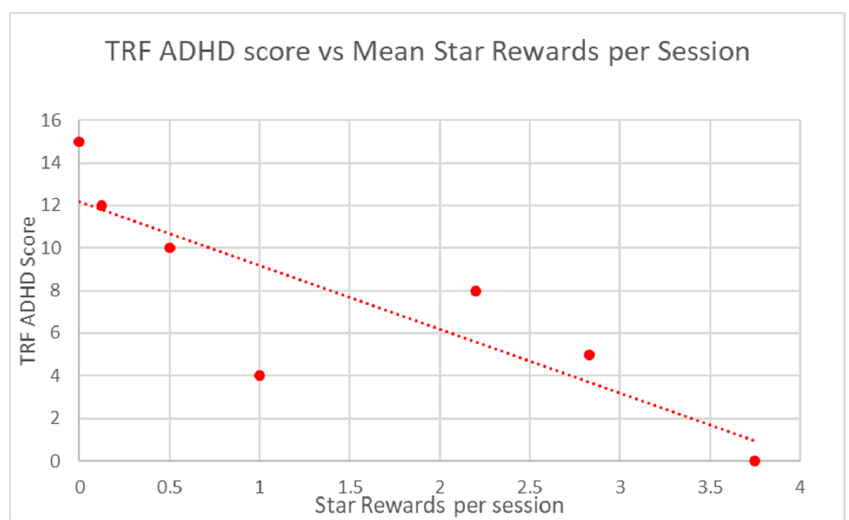
Figure 4. TRF ADHD score vs Mean Star Rewards per Session.